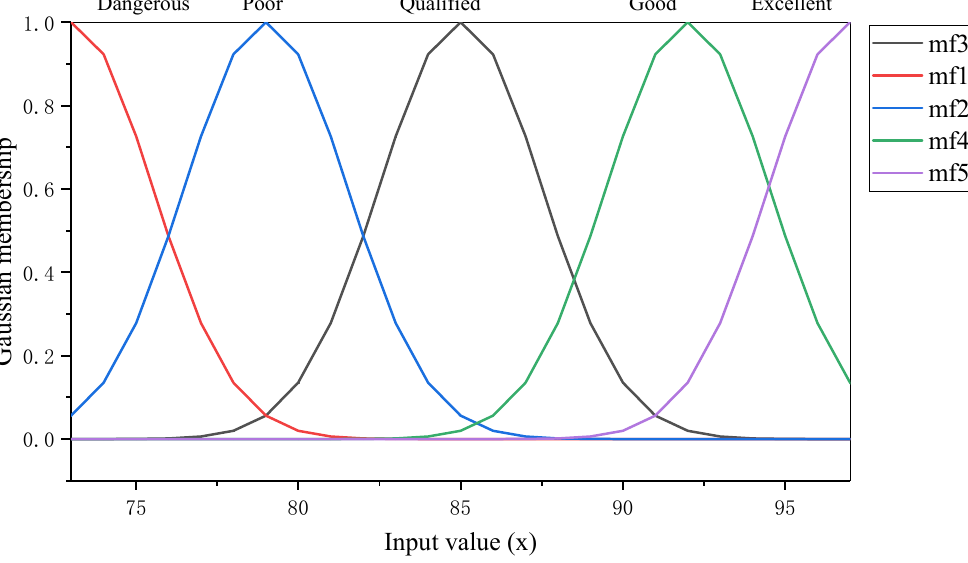
Figure 8. Degree function curve.